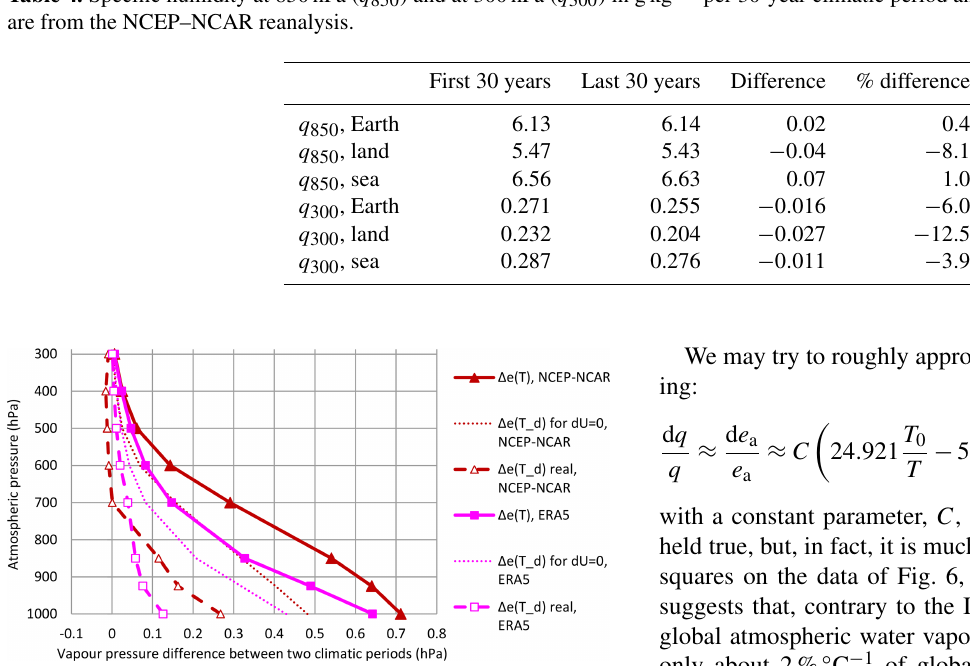
Figure 6. Vertical profile of the difference between two climatic periods of average water vapour pressure e(T ) and e(T d ) = Ue(T ) over land at levels of atmospheric pressure ranging from 1000